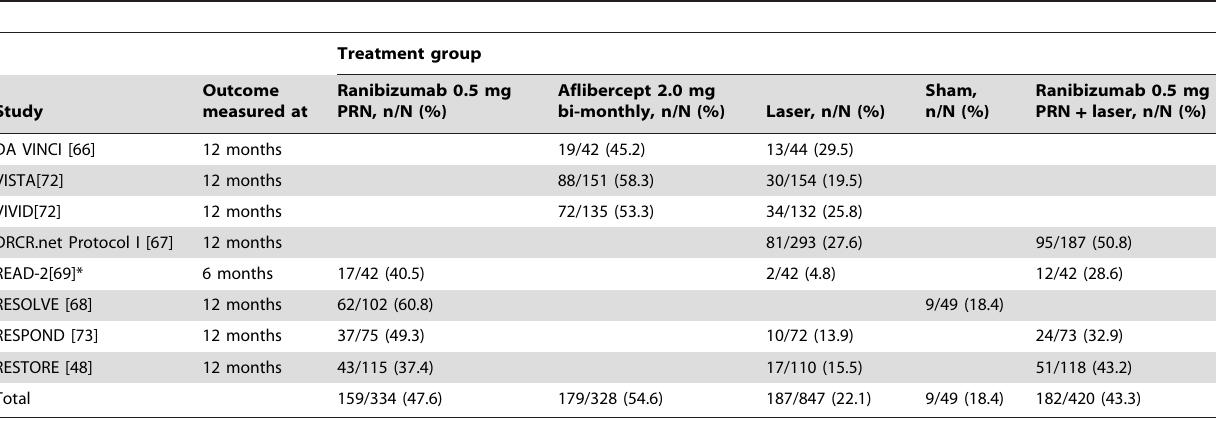
Table 1. Summary of the proportion of patients gaining $ 10 letters (BCVA) from baseline to month 12 by study and treatment group.